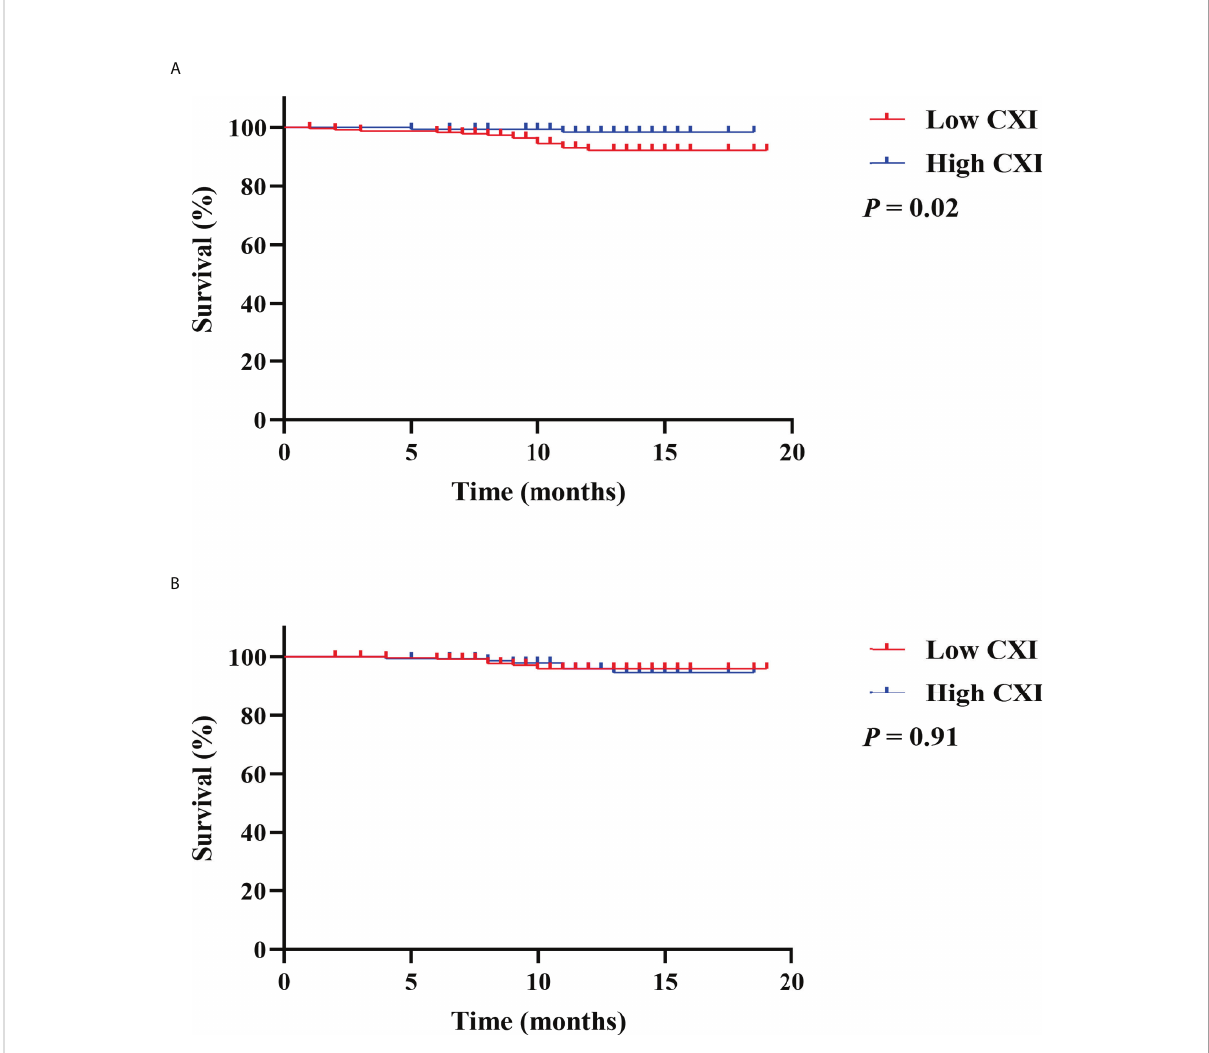
FIGURE 3 Kaplan Meier survival curves for the associations between cachexia index (CXI) and (A) overall survival; (B) recurrence free